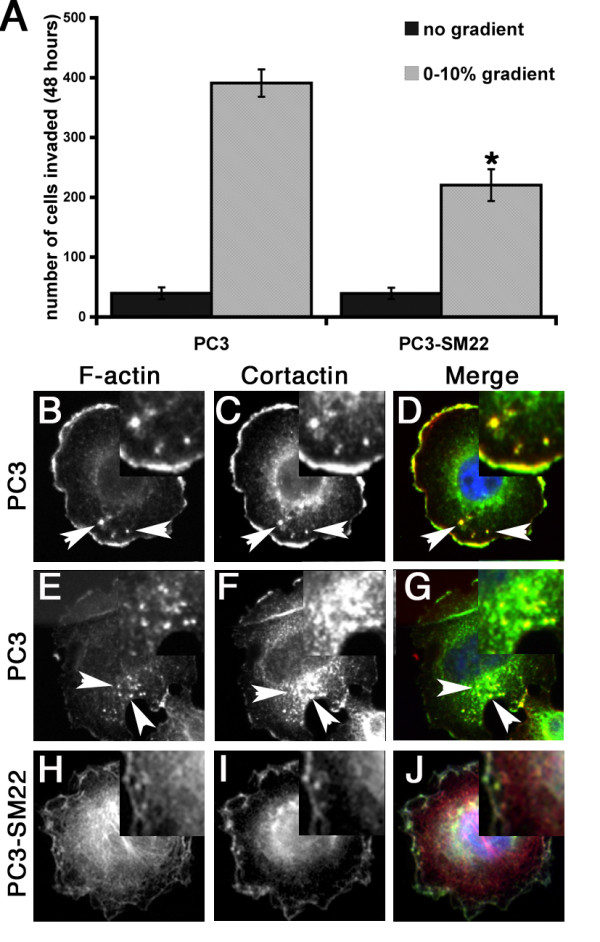
SM22 re-expression reduces PC3 Matrigel invasion and podosome formation. Re-expression of SM22 in PC3 cells reduces significantly the number of cells invading and traversing the filter in Matrigel coated Boyden chamber assays in response to a serum gradient (A); mean ± SEM 3 independent experiments, * p < 0.03 PC3 compared to PC3-SM22 in 0-10% gradient. PC3 cells stained for F-actin (B, E, H red in merge), cortactin (C, F, I green in merge). Cells in B-G are control PC3, cell in H-J is expressing SM22. Normal PC3 exhibit prominent ruffling membranes and podosomes (arrowed) as indicated by the co-staining of F-actin and cortactin, whereas SM22 expressing PC3 cells have reduced ruffling membranes and are devoid of podosomes.